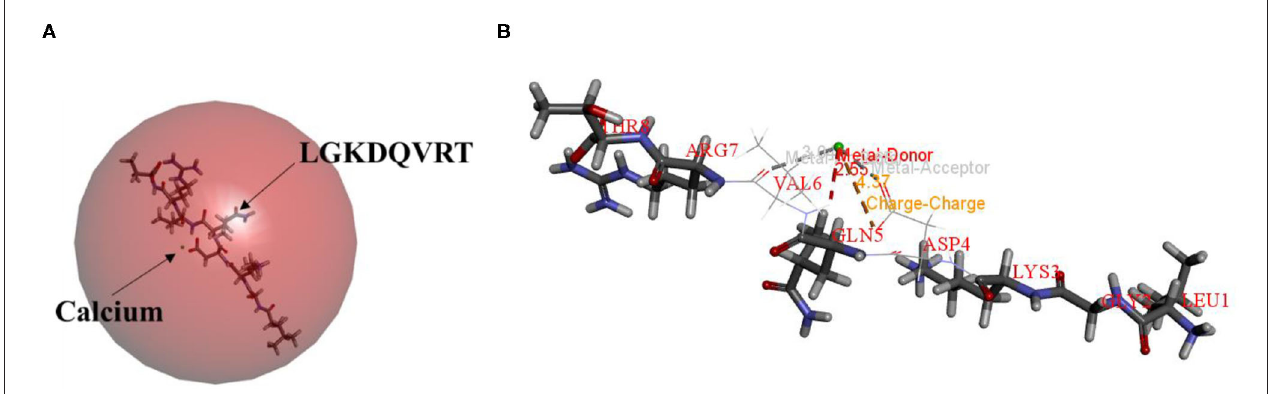
FIGURE 4 | Molecular docking and optimized structure of the LGKDQVRT-calcium complex. (A) 3D structure of LGKDQVRT-calcium complex as a surface image, generated by the surface menu of Discovery Studio 2017 software. (B) Interaction among ASP4, GLN5, and VAL6 in LGKDQVRT with calcium.